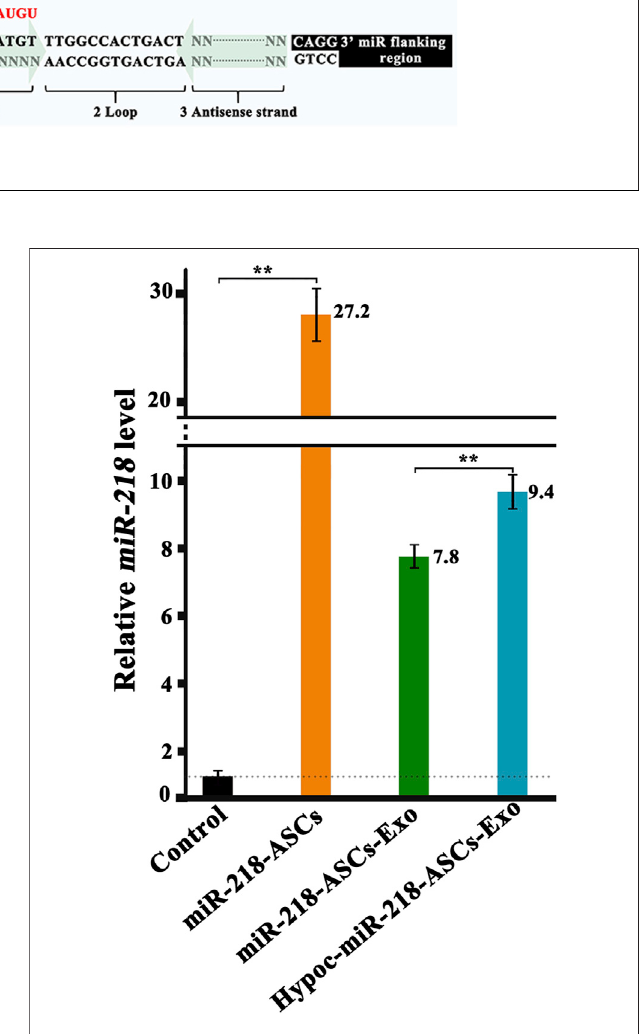
FIGURE 5 | Expression levels of miR-218 in untreated ASCs (normalization and served as the Control group, C group), transfected ASCs (miR-218-ASCs group), exosomes isolated from general environment culturedthetransfected ASCs,andexosomesisolatedfrom hypocapnia environment cultured the transfected